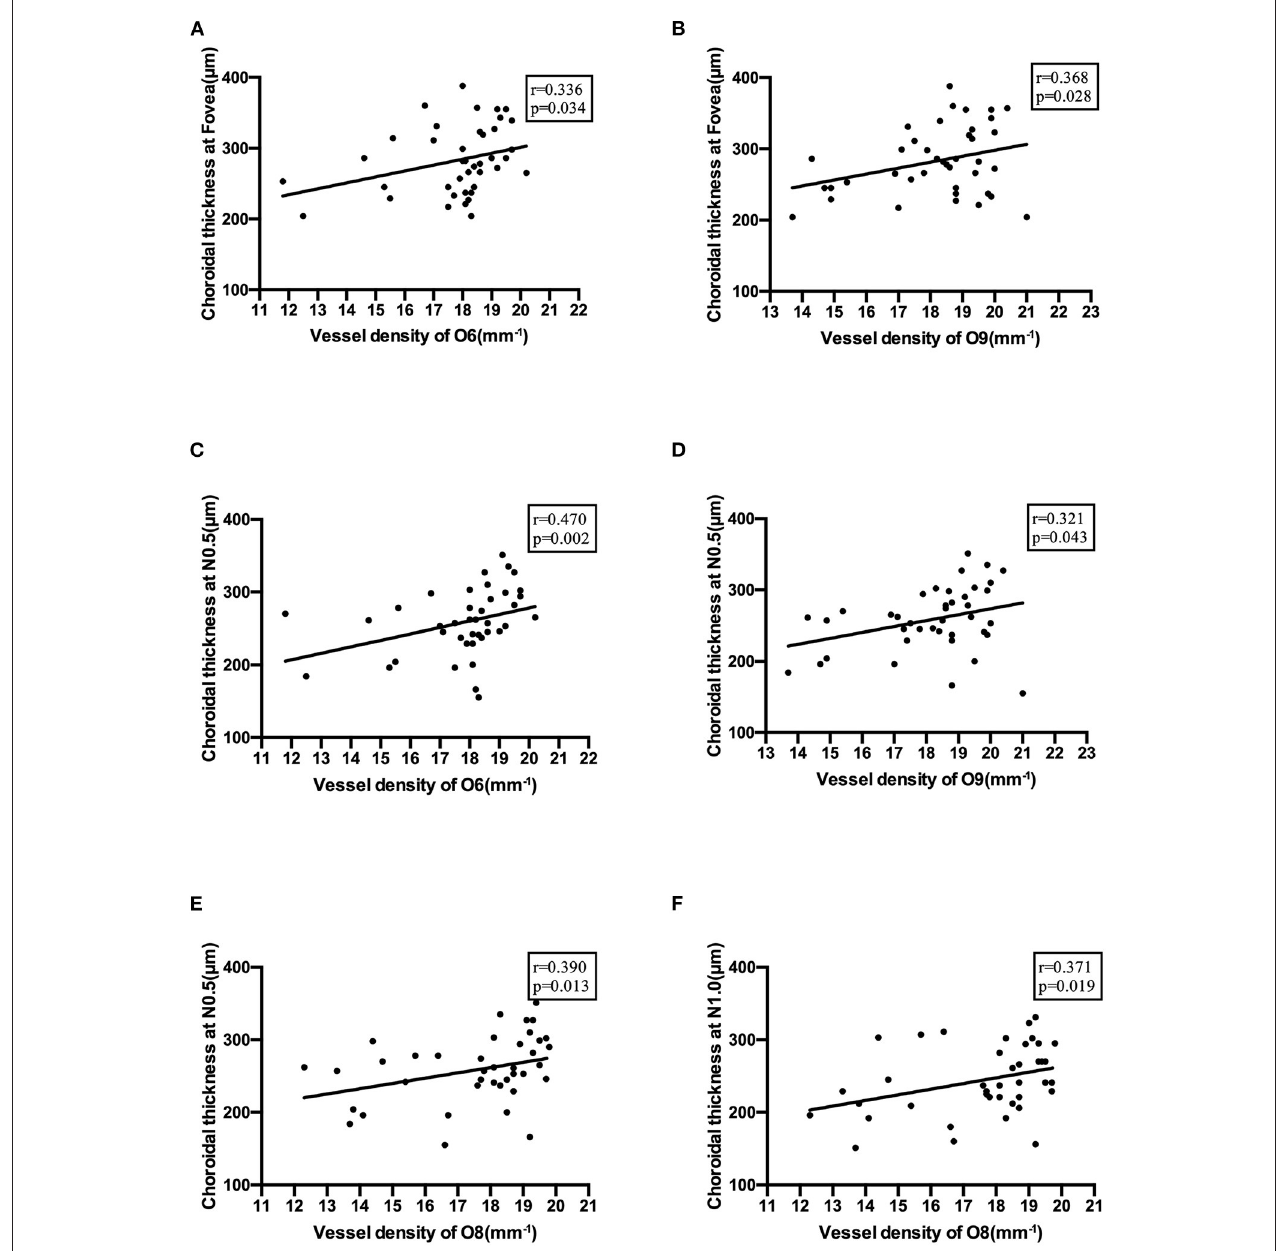
FIGURE 7 | Correlations between choroidal thickness and vessel density in the optic disc area. (A) Correlation of choroidal thickness at the fovea with vessel density in O6 section. (B) Correlation of choroidal thickness at the fovea with vessel density in O9 section. (C) Correlation of choroidal thickness at N0.5 with vessel density in O6 section. (D) Correlation of choroidal thickness at N0.5 with vessel density in O9 section. (E) Correlation of choroidal thickness at N0.5 with vessel density in O8 section. (F) Correlation of choroidal thickness at N1.0 with vessel density in O8